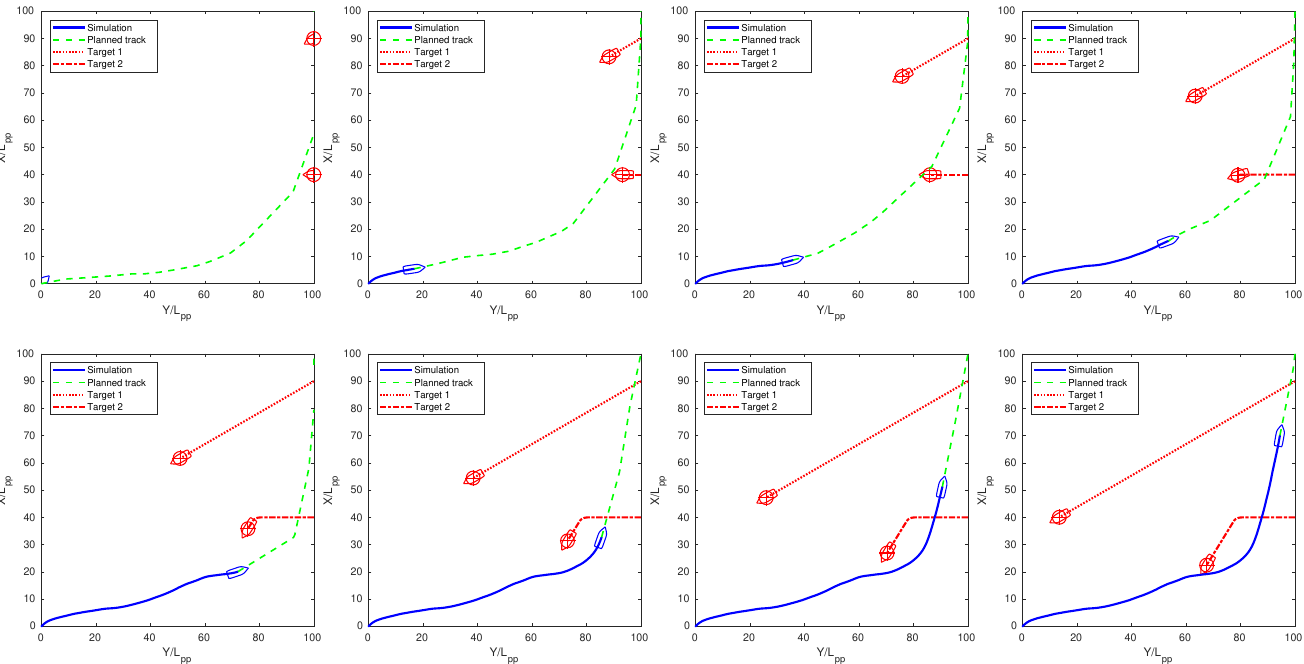
Figure 13. Scenario 2: simulation of a COLREG-compliant manoeuvre with unexpected target behaviour (minor course